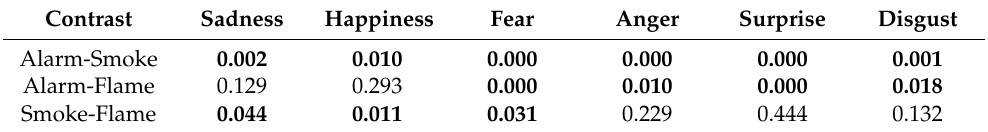
Table 3. p -Values of basic emotion